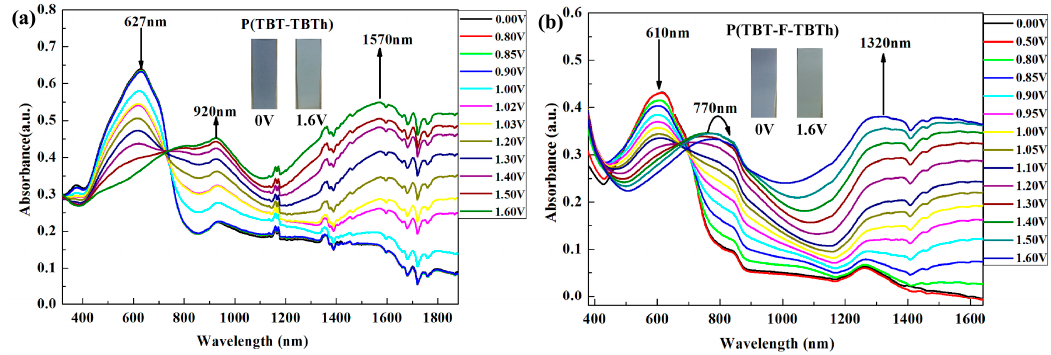
Figure 6. Spectroelectrochemical spectra of the polymer films: (a) P(TBT-TBTh); (b) P(TBT-F-TBTh).